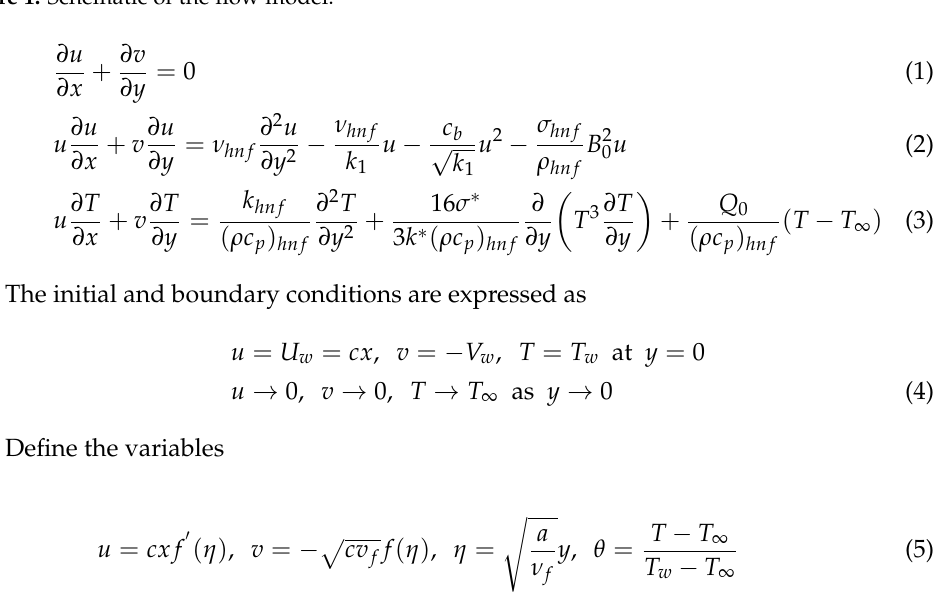
Figure 1. Schematic of the flow